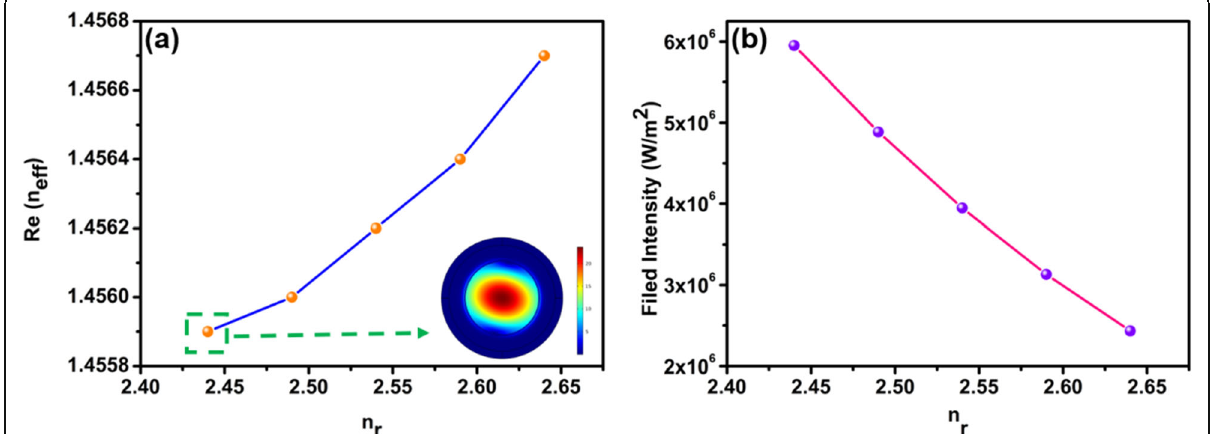
Fig. 14 a The mode real part of n eff as a function of n r for 150-nm WSe 2 nanosheet. And the inset is the electric field distribution of the mode with n eff of 1.4559. b Dependence of output electric energy on n r for 150-nm WSe 2